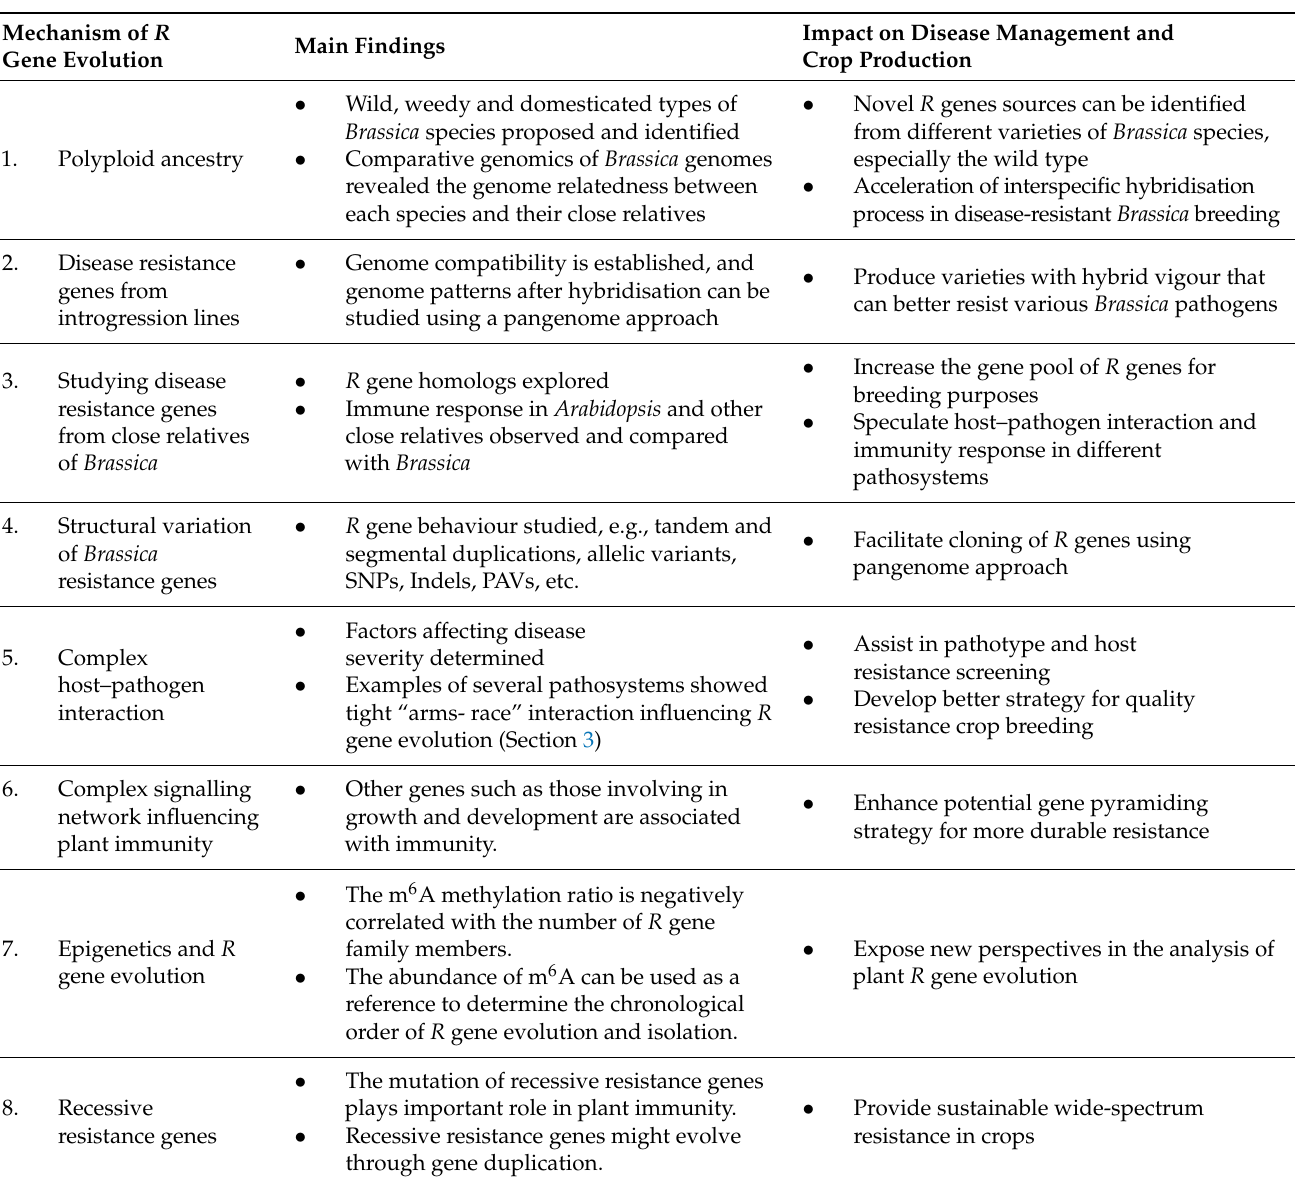
Table 1. Summary of the eight mechanisms of R gene evolution and their impact on disease manage- ment and crop